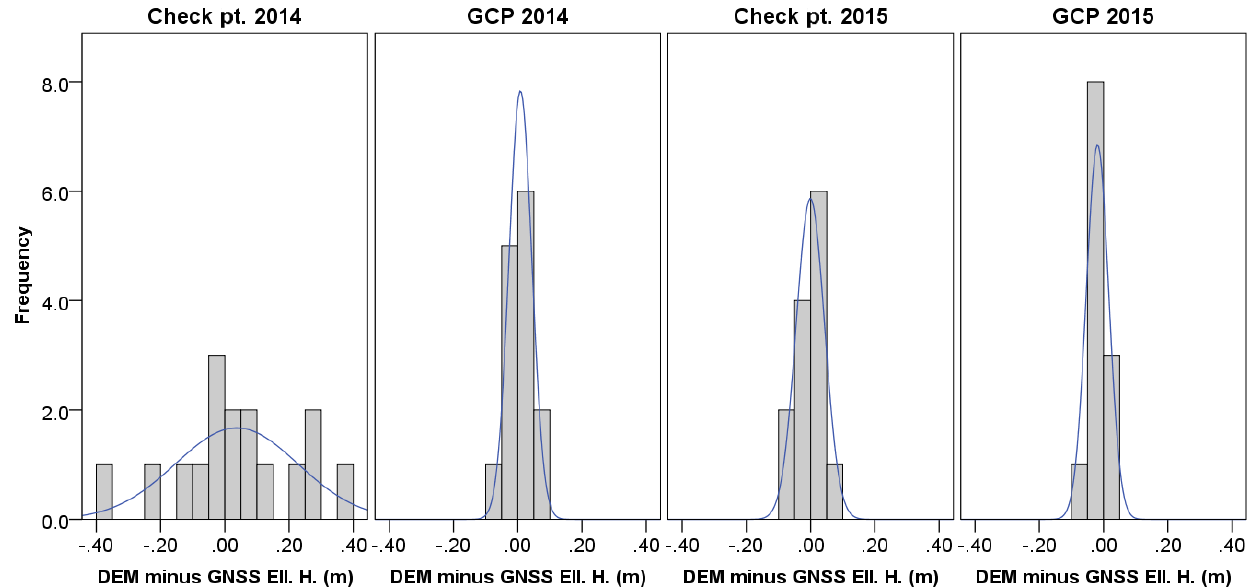
Figure 5. Histogram plot of elevation differences (errors) between check points and GCP surveyed elevations and DEM elevations for 2014 and 2015 respectively. Note: negative values indicate underestimation of DEM surface with respect to surveyed positions and thus imply flattening of the DEM surface. Most errors are less than ± 5cm and all within ± 10cm except for 2014 check points. Large 2014 check point errors are assumed to be the result of poor location